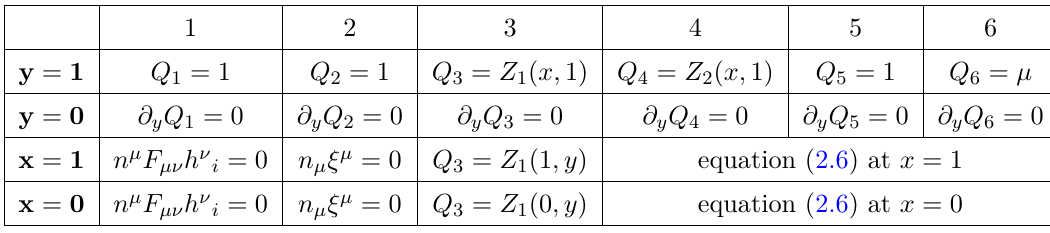
equation (2.6) at x = 0